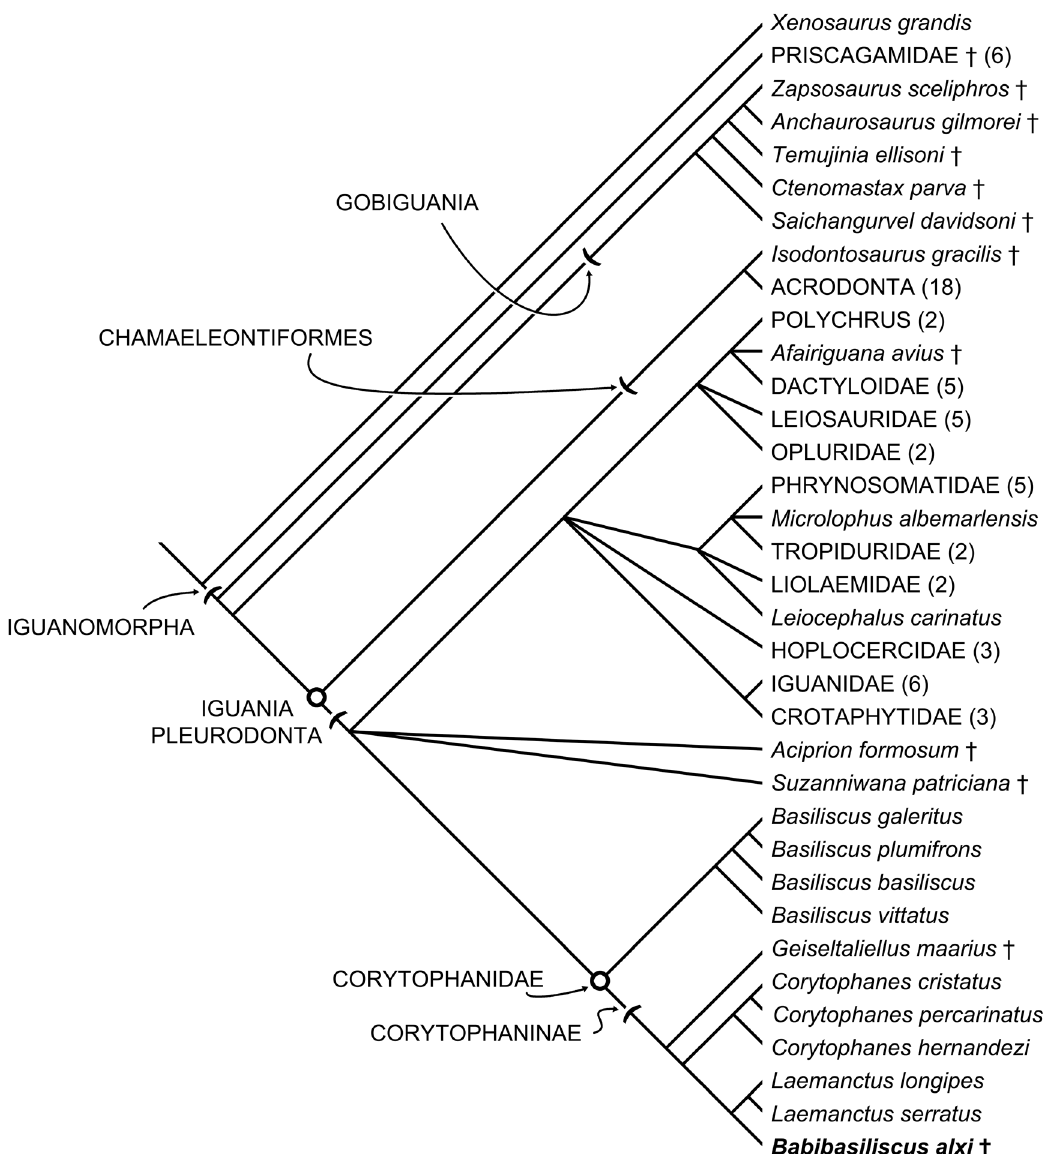
Fig 6. Phylogenetic hypothesis of Iguanomorpha based on the current analysis. This is the Adam ’ s consensus of 98 trees. Suzanniwana patriciana and Aciprion formosum are the taxa with the most volatile positions within this